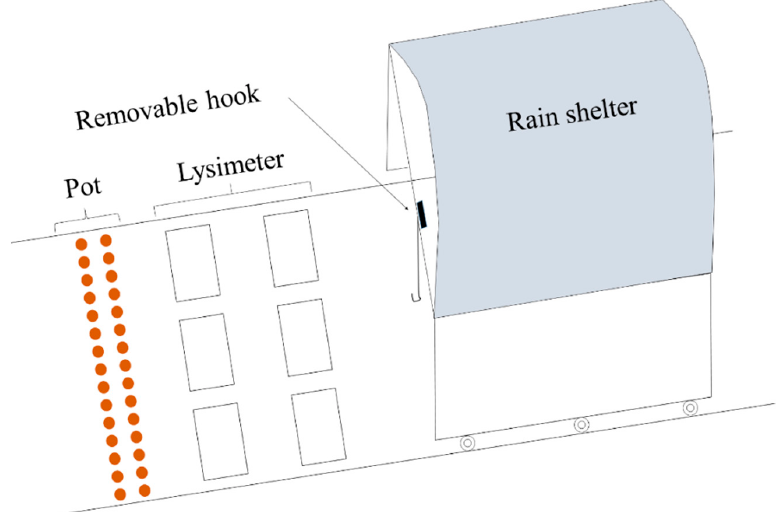
Figure 2. A schematic sketch of the devices for the pot and lysimeter experiments.